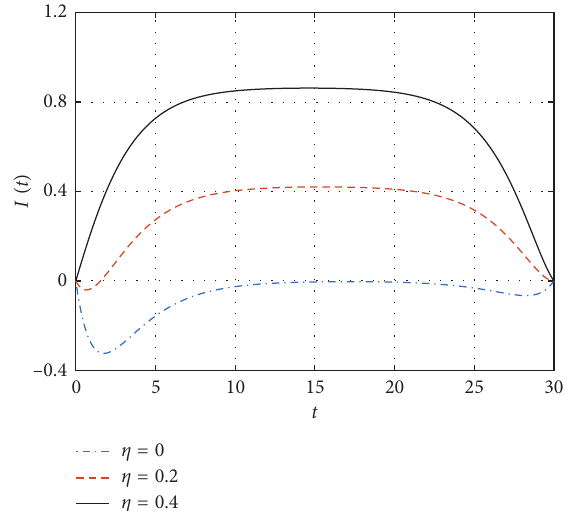
Figure 4: The optimal inventory with different values of param- eters η .